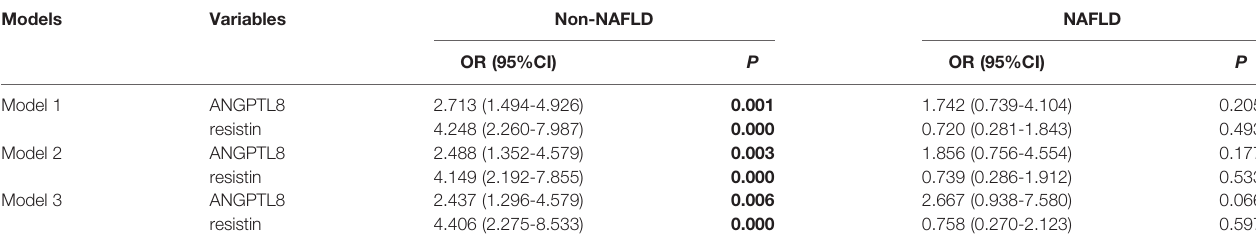
TABLE 4 | Logistic regression analysis of ANGPTL8 and resistin respectively for diabetic nephropathy in the non-NAFLD and NAFLD population. Models